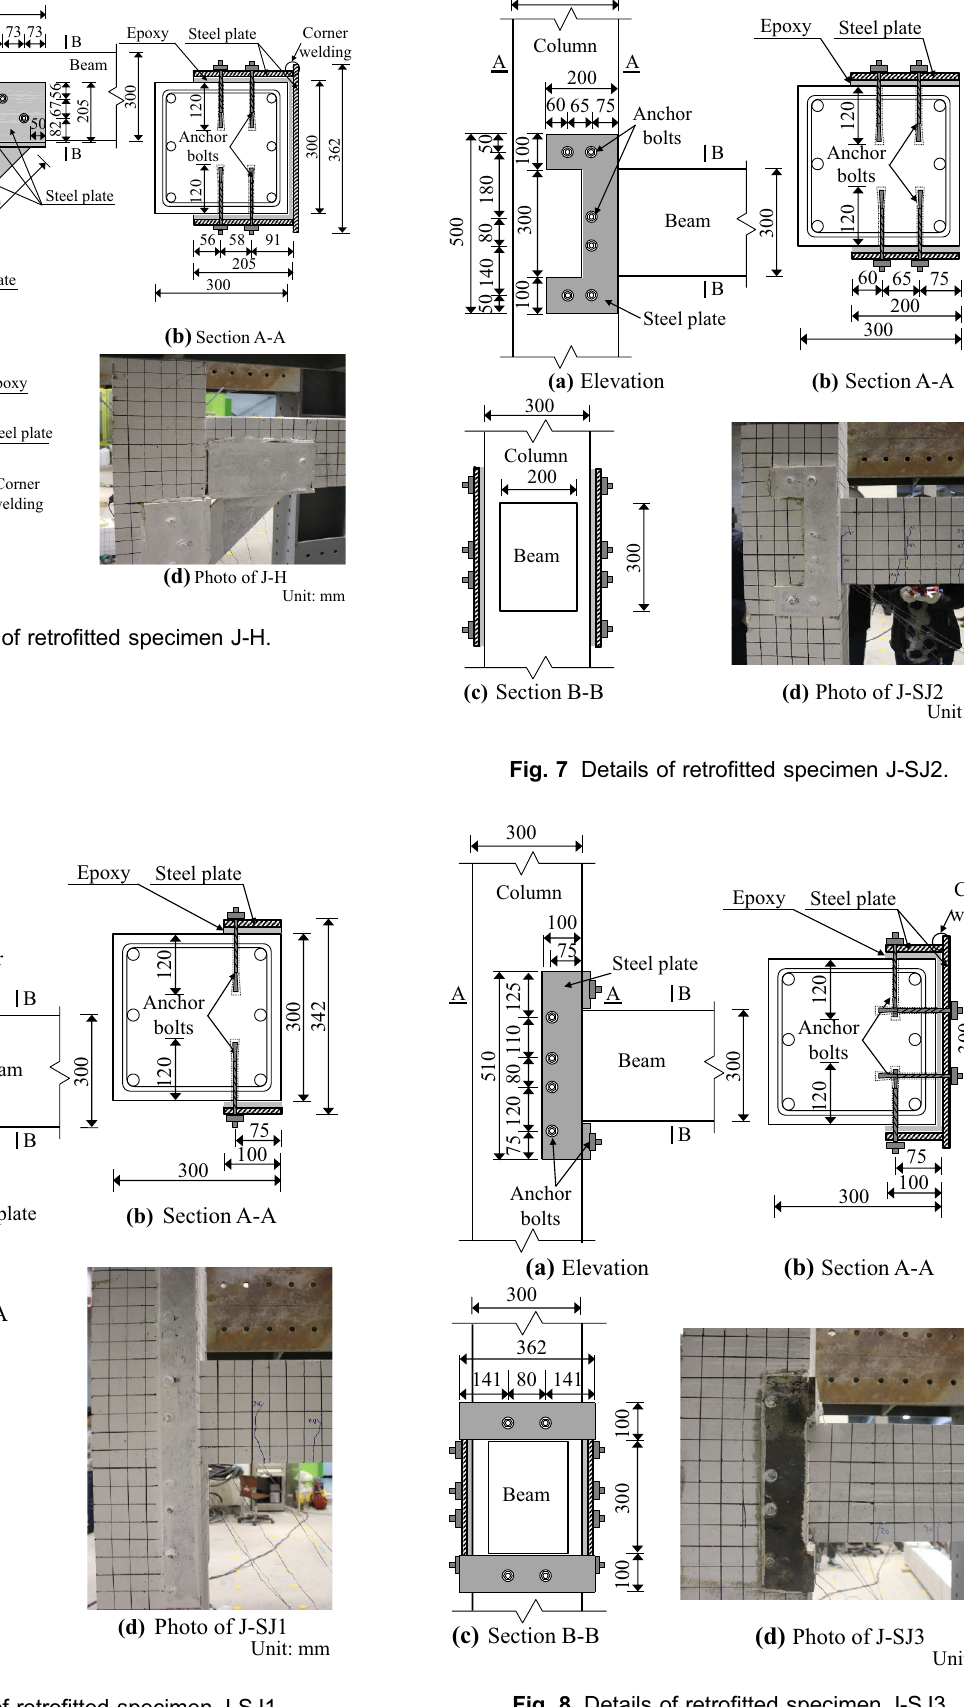
Fig. 6 Details of retrofitted specimen J-SJ1.